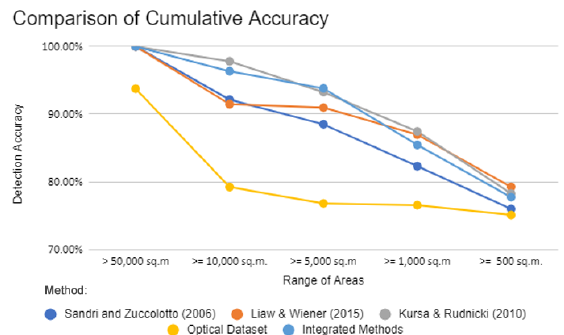
Figure 6. Cumulative Accuracies of different methods in detecting agri-urban